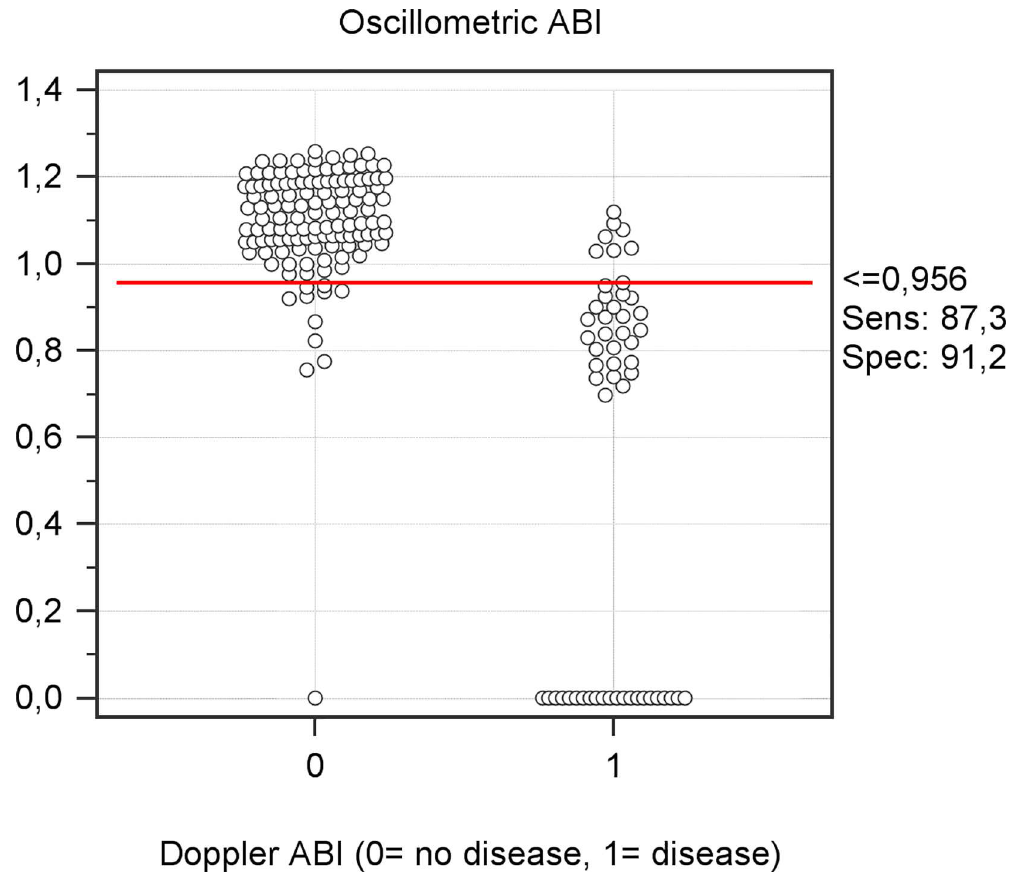
Fig 5. Interactive dot diagram of oscillometer and Doppler ABI. It depicts how the best cut-off (0.956) classifies oscillometric measurements regardingDopplerABI as well as measurement errors. There were 23 oscillometric measurement errors, of those, only one had a normal